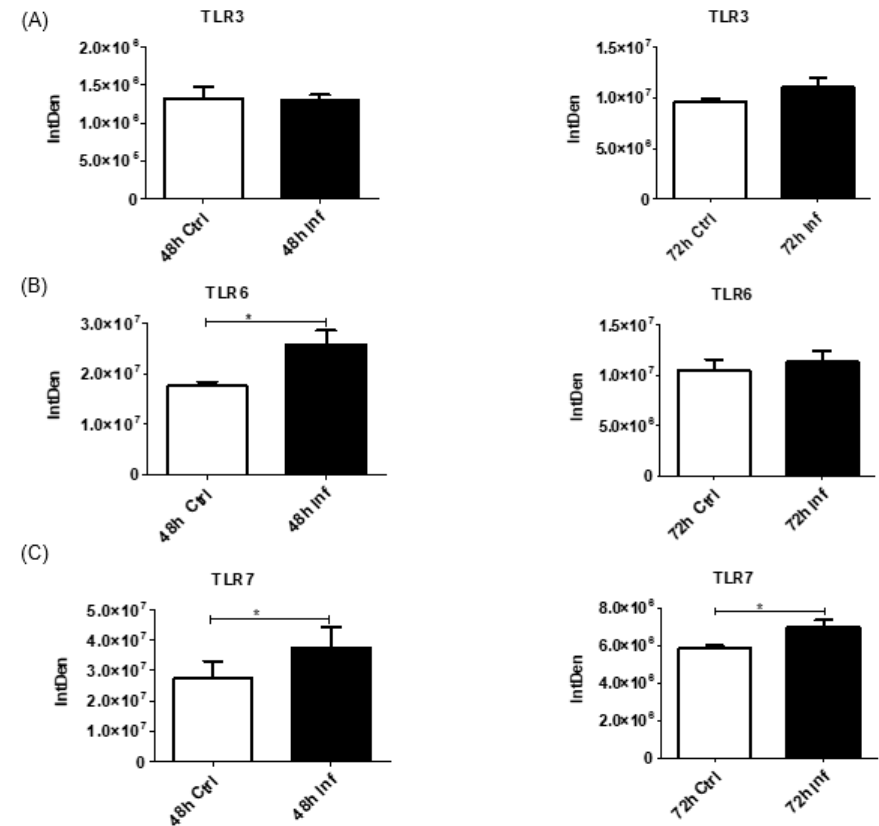
Figure 5. Activation of pathogen recognition molecules in response to CCoV infection. Graphs showing densitometric analysis of dot blot of ( A ) double ‐ stranded RNA sensor TLR3 level at 48 h and 72 h (Supplemental Figure S2F), ( B ) lipopolysaccharide sensor TLR6 level at 48 h and 72 h (Supplemental Figure S2G), and ( C ) RNA sensor TLR7 level at 48 h and 72 h (Supplemental Figure S2H), via Bio ‐ Rad imaging program and GraphPad Version 5 software in isolated control and infection ‐ derived EVs. Statistical analysis of obtained data points was performed using one ‐ way ANOVA with Tukey post hoc analysis. Statistical significance is indicated by the mean ± SD and is defined as p ≤ 0.05 (*).